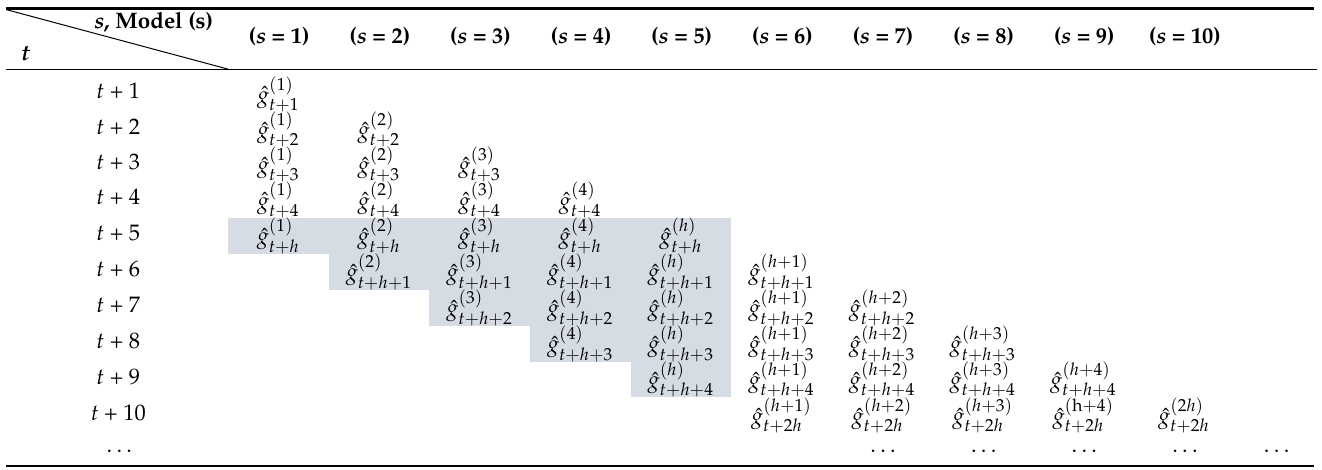
Table 1. Forecasts for the case h = 5 .